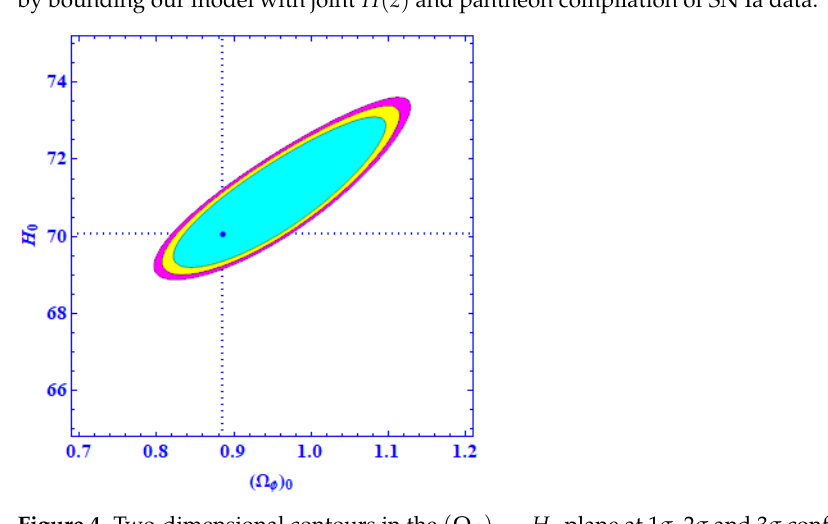
Figure 4. Two-dimensional contours in the ( Ω φ ) 0 − H 0 plane at 1 σ , 2 σ and 3 σ confidence regions by bounding our model with joint H ( z ) and pantheon compilation of SN Ia